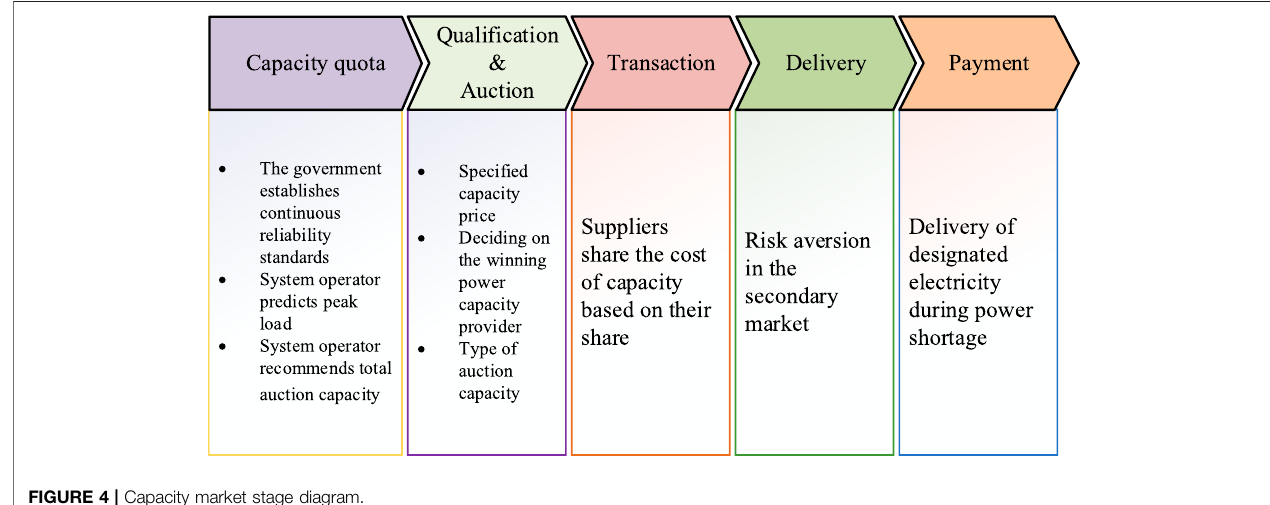
FIGURE 4 | Capacity market stage diagram.